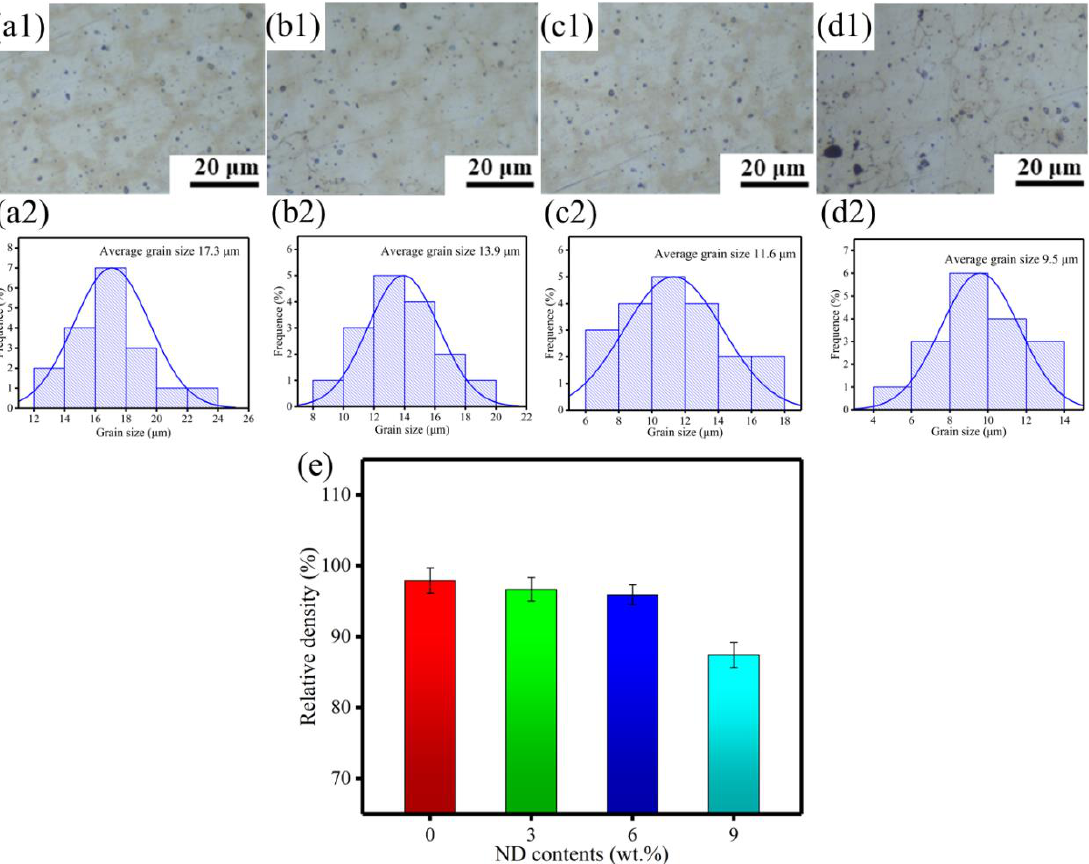
Figure 2. Metallographic structure and corresponding grain size distribution of ZK60−xND: ( a1 , a2 ) ZK60, ( b1 , b2 ) ZK60−3ND, ( c1 , c2 ) ZK60−6ND, ( d1 , d2 ) ZK60−9ND, respectively; ( e ) relative density of SLMed ZK60−xND.